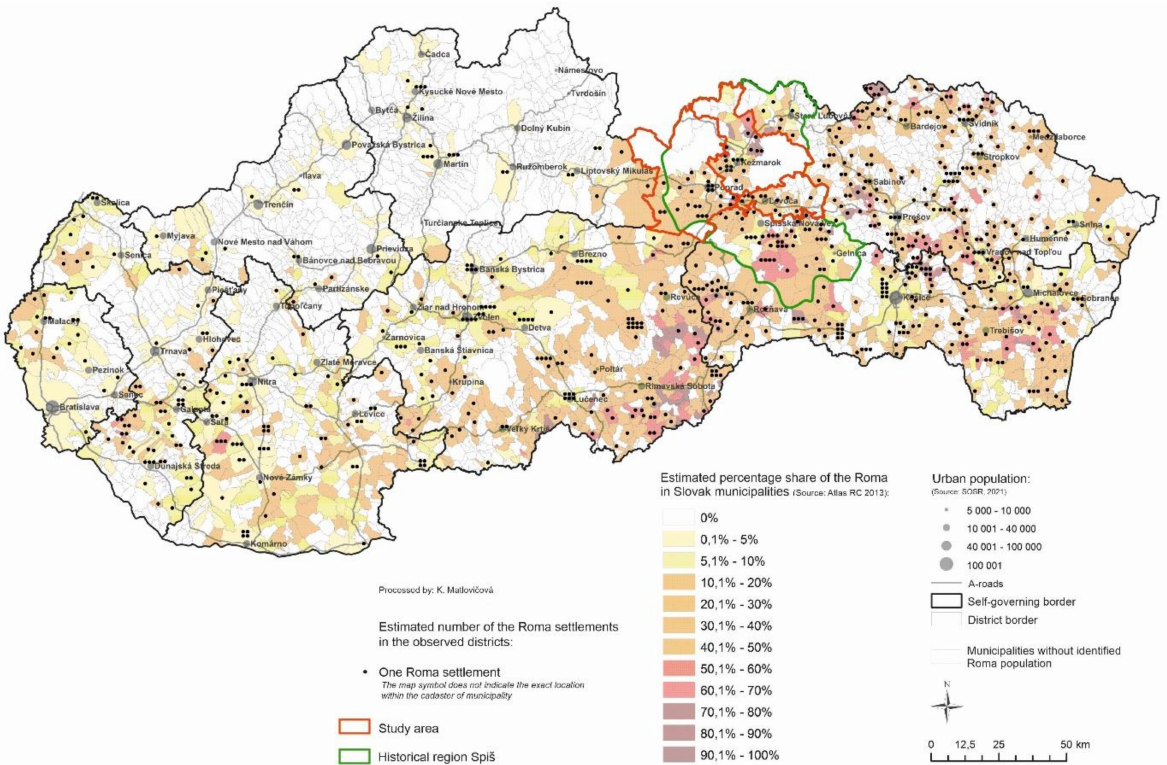
Figure 1. Location of the study area within Slovakia. Source: based on data from